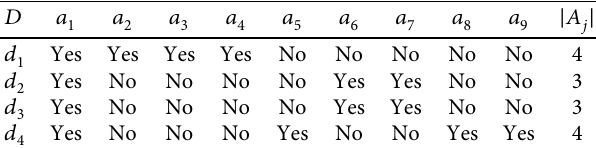
Table 8: Parameters-diseases relation.